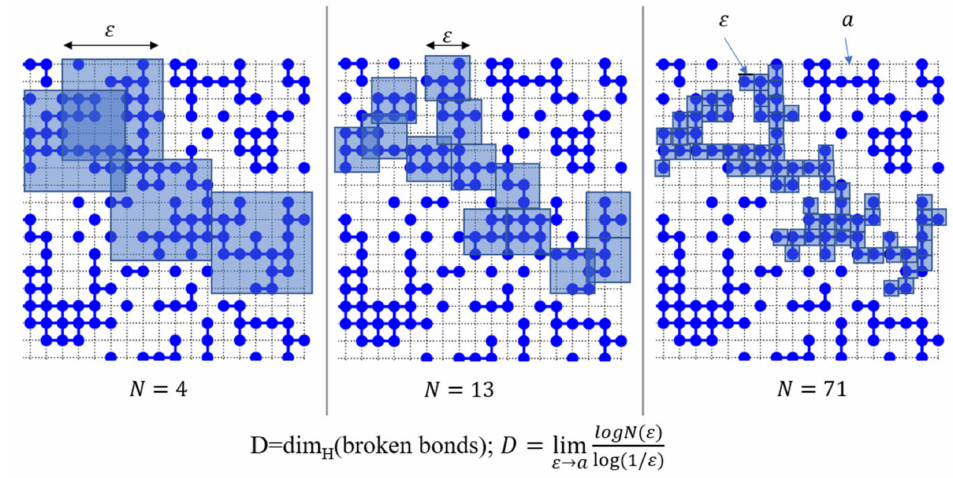
Figure 4. Schematic of finding Hausdorff–Besicovitch dimension D of the percolation cluster made of a set of connecting sites representing configurons on a planar square lattice of bonds. Blue dots are configurons, and the percolation is evidenced by the connecting pathway from the left to right sites of the square. The theoretical result for two-dimensional square lattices is D = 1.896, and the percolation threshold p c = 0.59, meaning that 59% of bonds shall be broken in order for percolation via broken bonds to occur